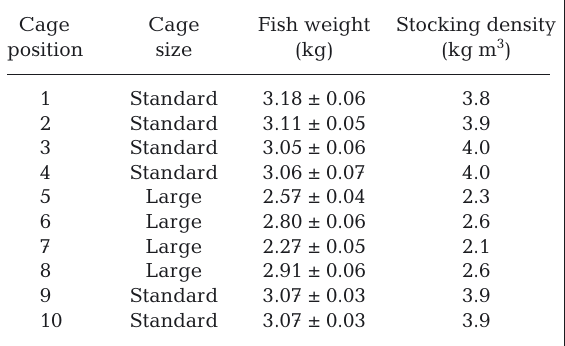
Table 1. Cage position (Fig. 1), cage size, and weight (mean ± SD) and stocking density of Atlantic salmon in each cage